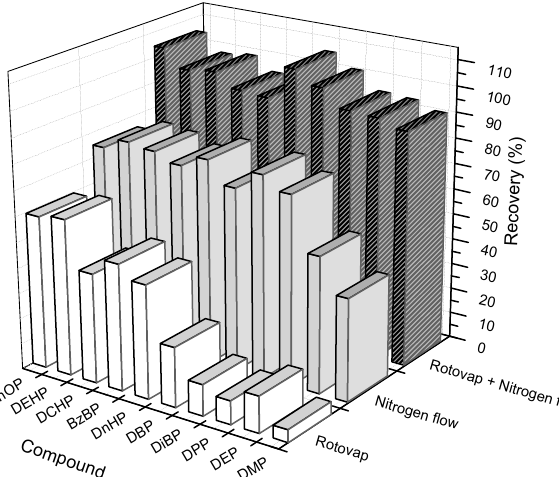
Figure 1. Comparison of recoveries between variable solvent evaporation methods. Note: Dimethyl phthalate, DMP; Diethyl phthalate, DEP; Dipropyl phthalate, DPP; Diisobutyl phthalate, DiDP; Benzyl